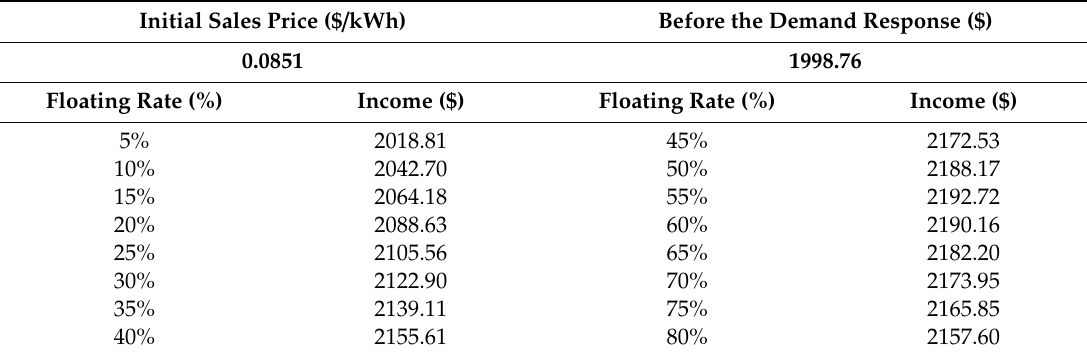
Table 5. The income change of the microgrid under di ff erent floating ratios in the real-time market.